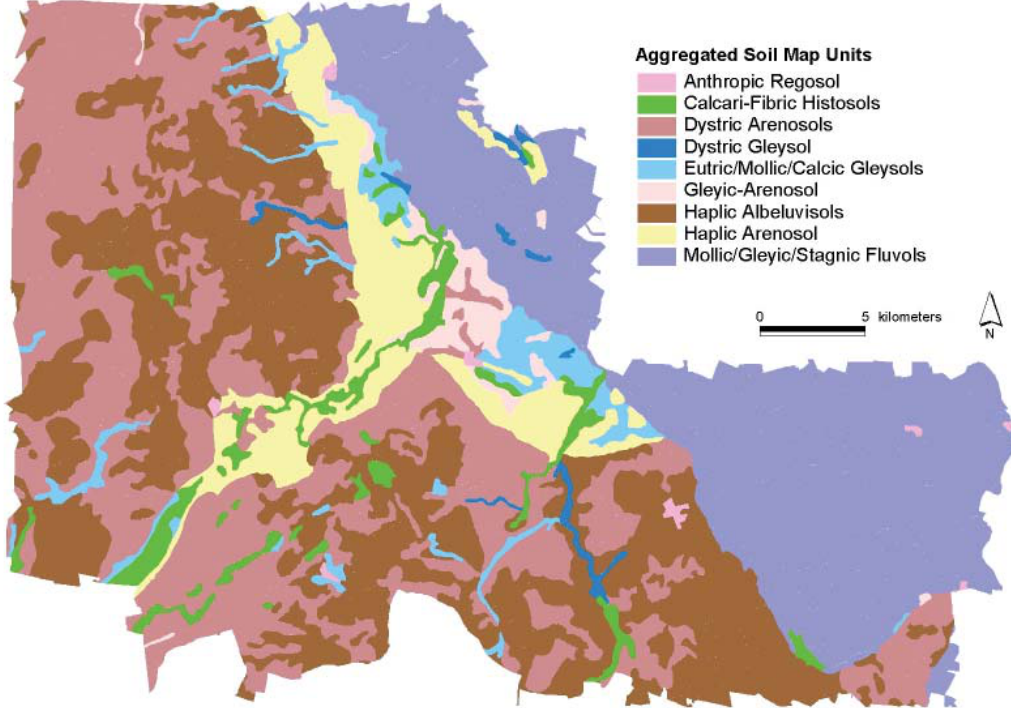
Figure 3. Aggregated soil map of the research area based on FAO-classification, derived from digi- tal German Soil Survey Map of Germany 1:300.000 (BÜK